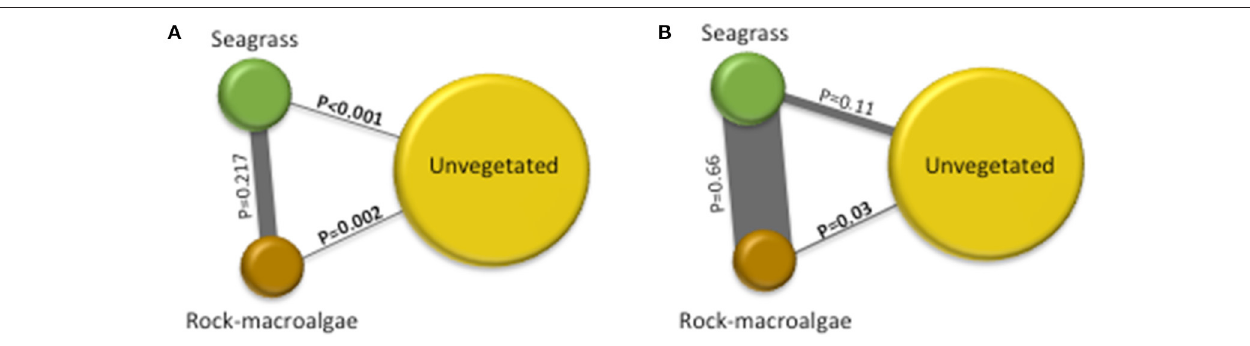
The assemblage structure of fish ( Figure 3 ) varied significantly among the three habitats (ANOSIM; Global R = 0.435, p < 0.001), with seagrass- and rock-macroalgae-habitats